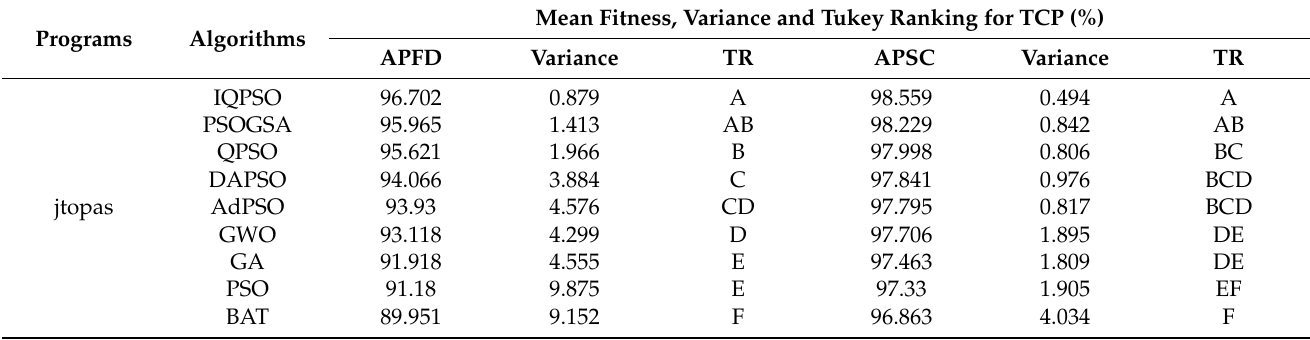
Table 4. Comparisons of the algorithms for TCP over fault and statement